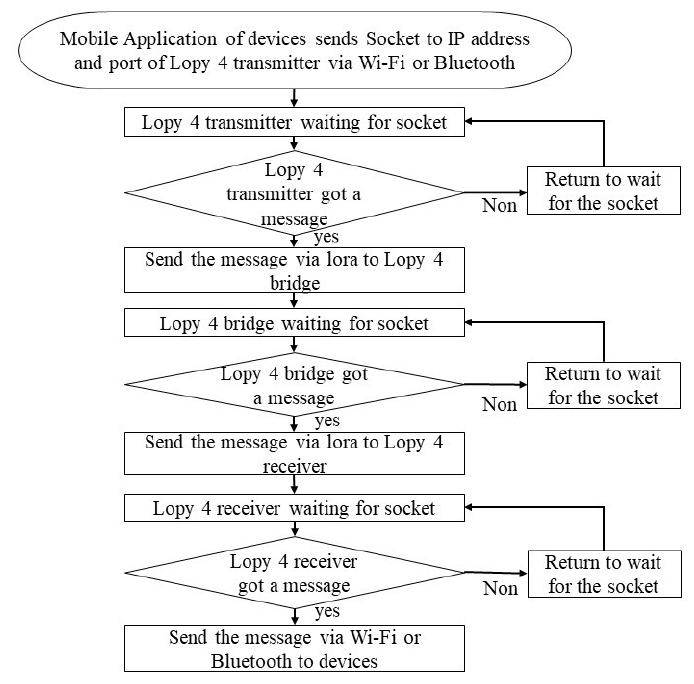
Figure 5. A visualization of the APCAM Model.